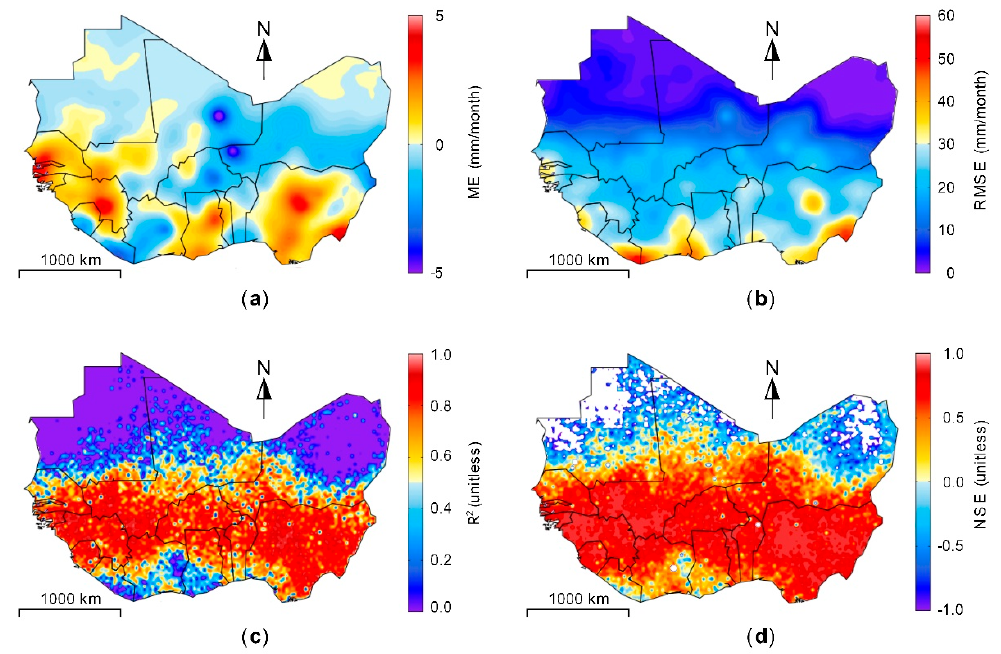
Figure A1. Validation of artificial neural network-based learning machine (ANN NARX) predicted African Rainfall Climatology (ARC) v2 rainfall data. ( a ) Mean error—ME; ( b ) Root-mean-square error—RMSE; ( c ) Coefficient of determination— R 2 ; and ( d ) Nash-Sutcliffe efficiency coefficient— NSE.